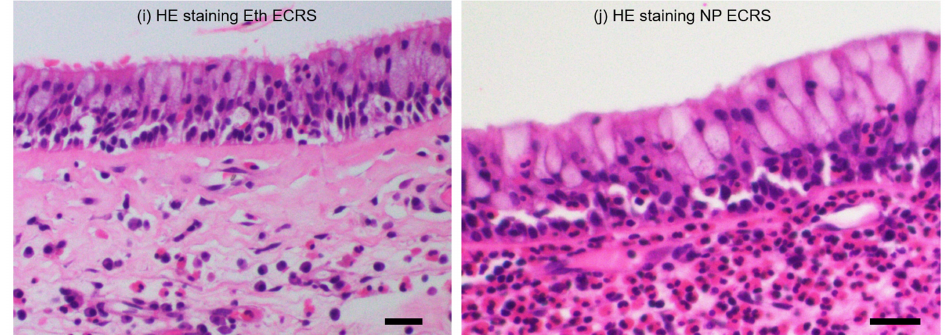
Figure 4. Representative immunohistological images showing T2R38 ( a – c ) and T2R14 ( e – g ) protein distribution in ethmoid sinus and nasal polyp mucosa sampled from non-ECRS and ECRS patients. Isotype negative controls for T2R38 ( d ) and T2R14 ( h ). HE staining images of ( i ) ethmoid mucosa and ( j ) nasal polyps obtained from the same ECRS patient. Epithelial ciliated cells stained positive for T2R38. Higher rates of staining were observed in epithelial cells in ECRS patients along the ciliated luminal surface (Figure 4b, arrowheads). In contrast, secretary goblet cells in the epithelial layer generally show a lack of staining (Figure 4c, asterisks). Positive T2R14 immunoreactivity is localized mainly to epithelial cells with cytoplasmic staining. Scale bar: 20 µ m.